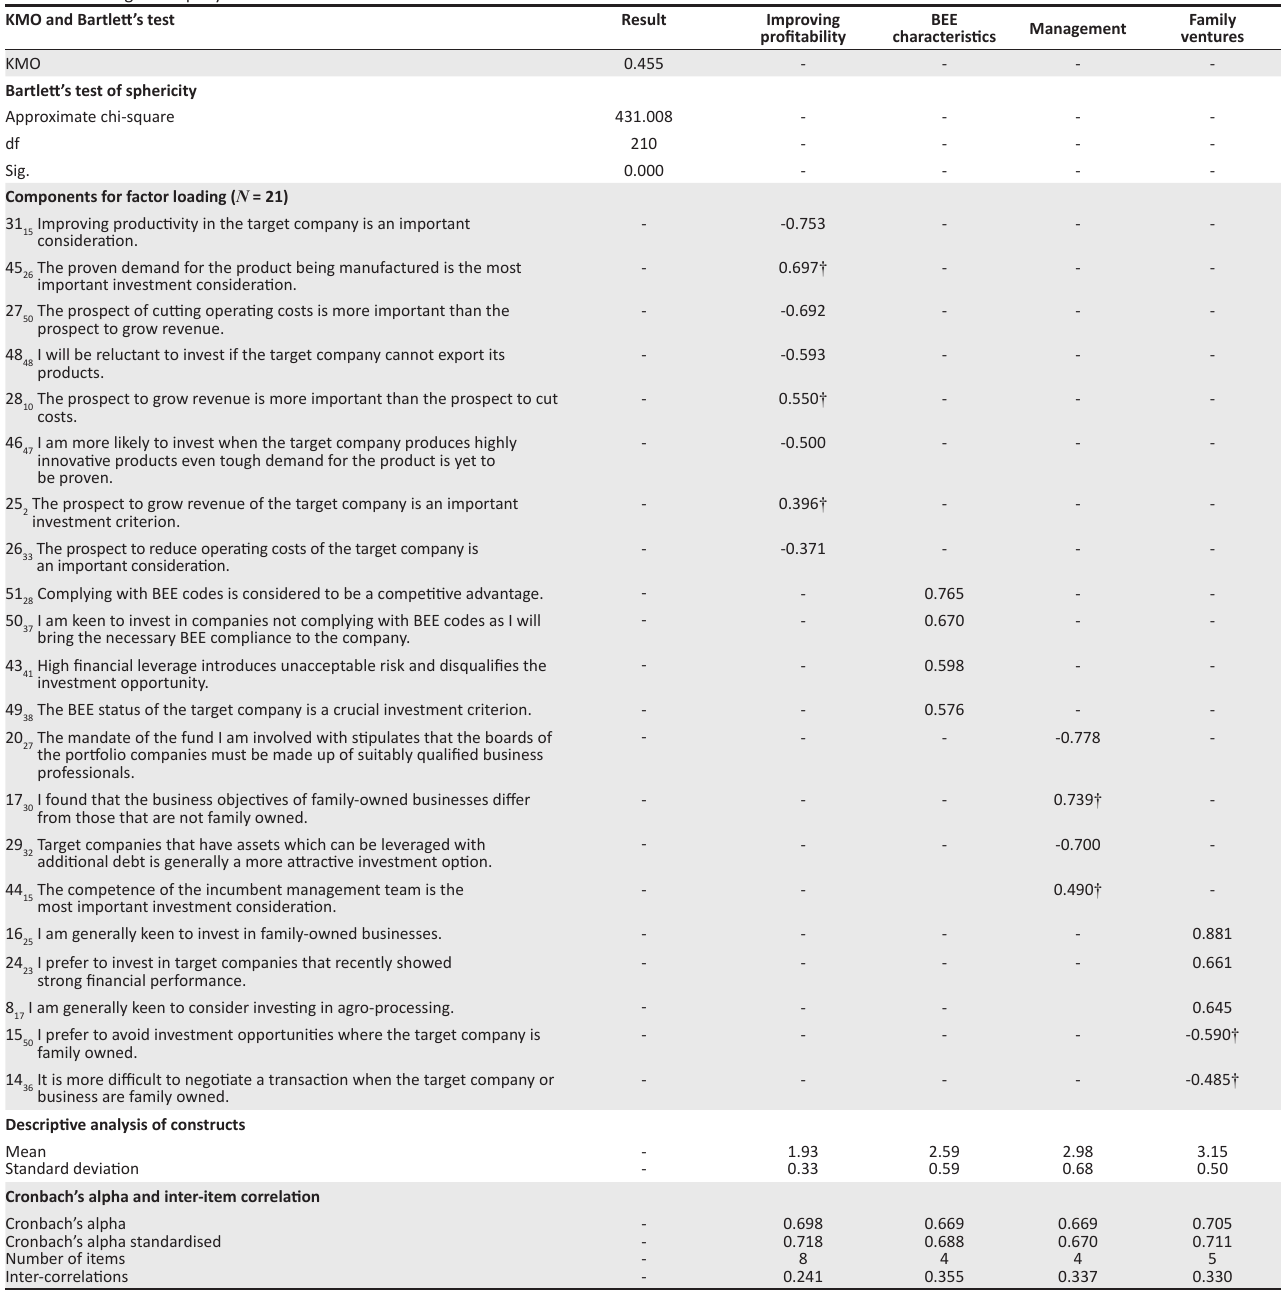
TABLE 2-A1: Target company characteristics. KMO and Bartlett’s